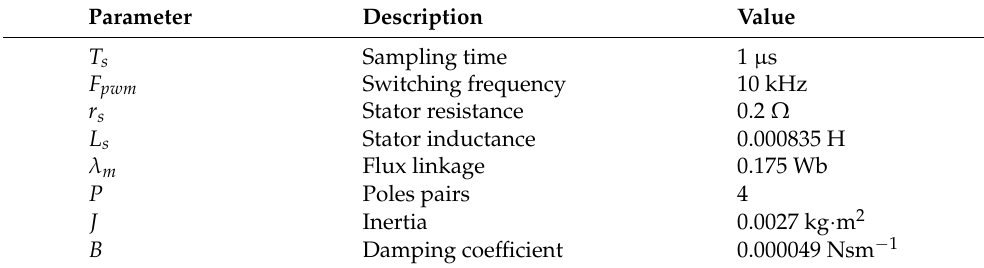
Table 1. SPMSM parameter values.